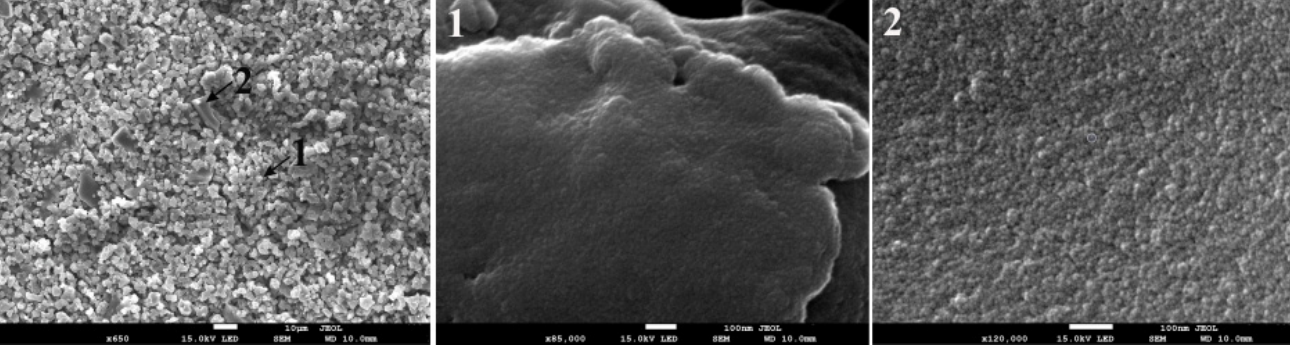
Figure 12. SEM images of the char produced at 623 K and 10 min residence time. High magnification images of the regions marked as 1 and 2 are displayed in the middle and the right panel respectively.